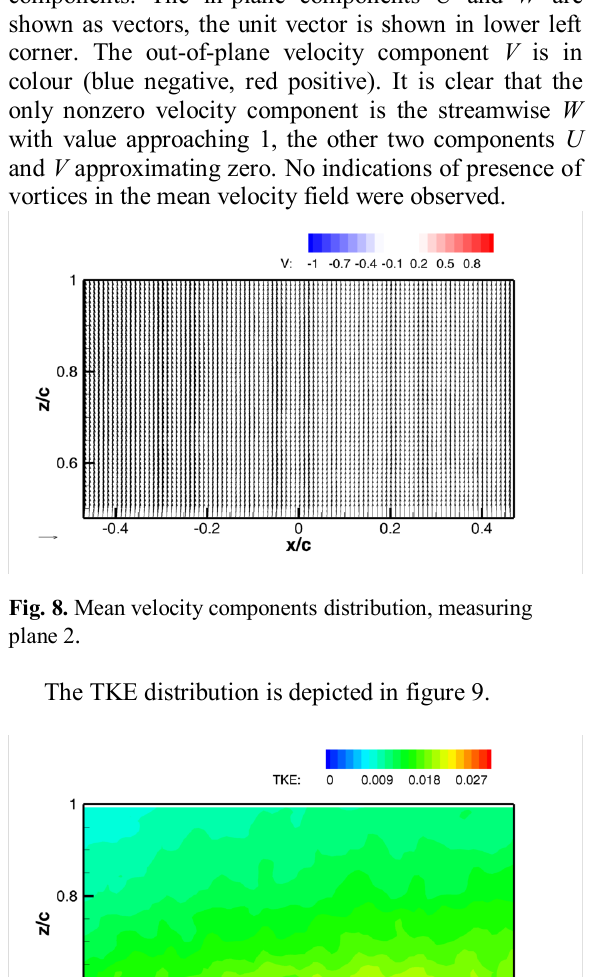
Fig. 10. Instantaneous vector fields, measuring plane 2 (3 examples)